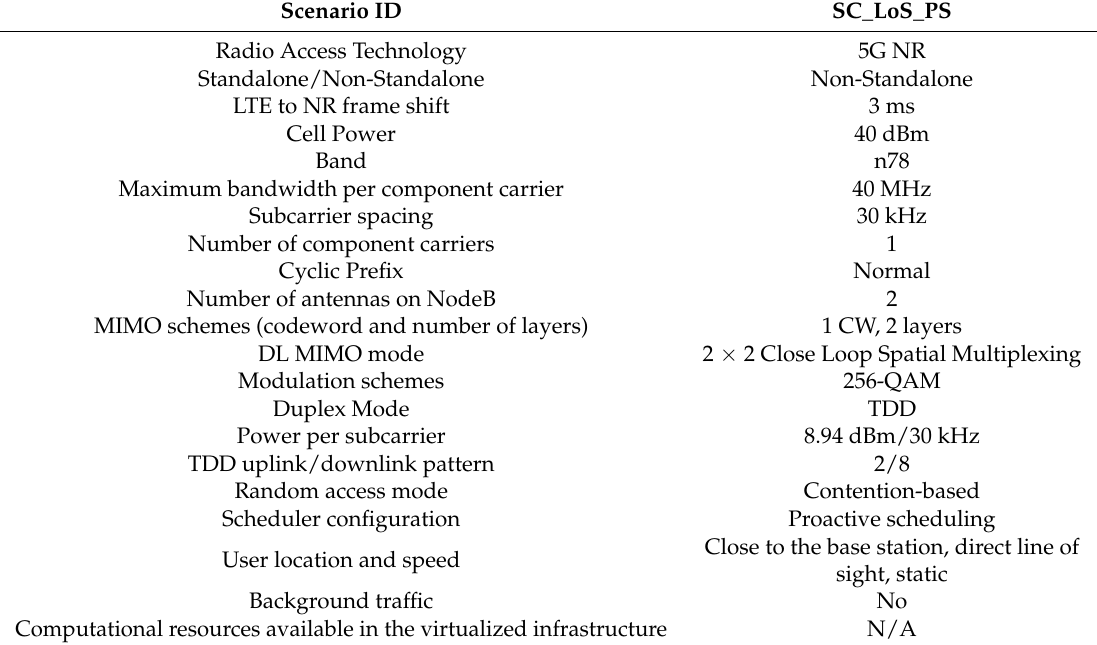
Table 3. Scenario template applied to a 5G NR NSA deployment with Line of Sight (LoS) between gNB and UE. The scenario (SC) is denoted SC_LoS_PS, where PS stands for Proactive Scheduling, a vendor-specific configuration available in the gNB (cf. Section 5.3 for more